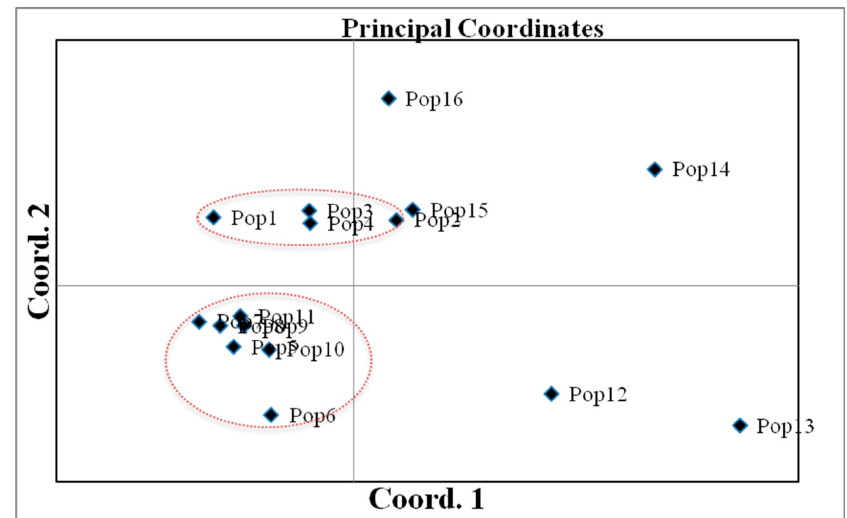
Figure 3. Scatter plot obtained from principal coordinate analysis based on the genetic distance derived from expressed sequence tag-simple sequence repeats (EST-SSR) markers in 16 populations. The first axis for 6.7% and the second axis for